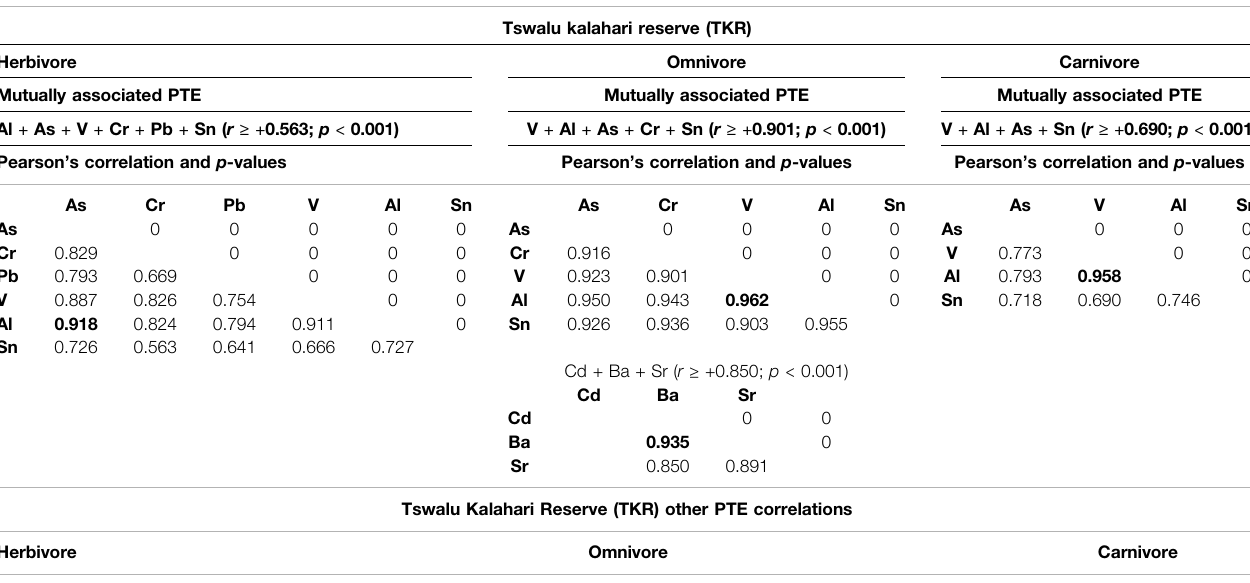
TABLE 2 | Mutually associated PTEs and other PTE correlations at the Tswalu Kalahari Reserve (TKR) in different trophic groups. Grey highlighted blocks with bold lettering showhighestmutuallyassociatedPTEforrespectivetrophicgroups.BoldtextrepresentsthehighestmutuallycorrelatedelementsandothercorrelatedPTEsforspeci fi c trophic groups. Faecal concentrations are given as microgram per kilogram (µg/kg) faecal dry mass